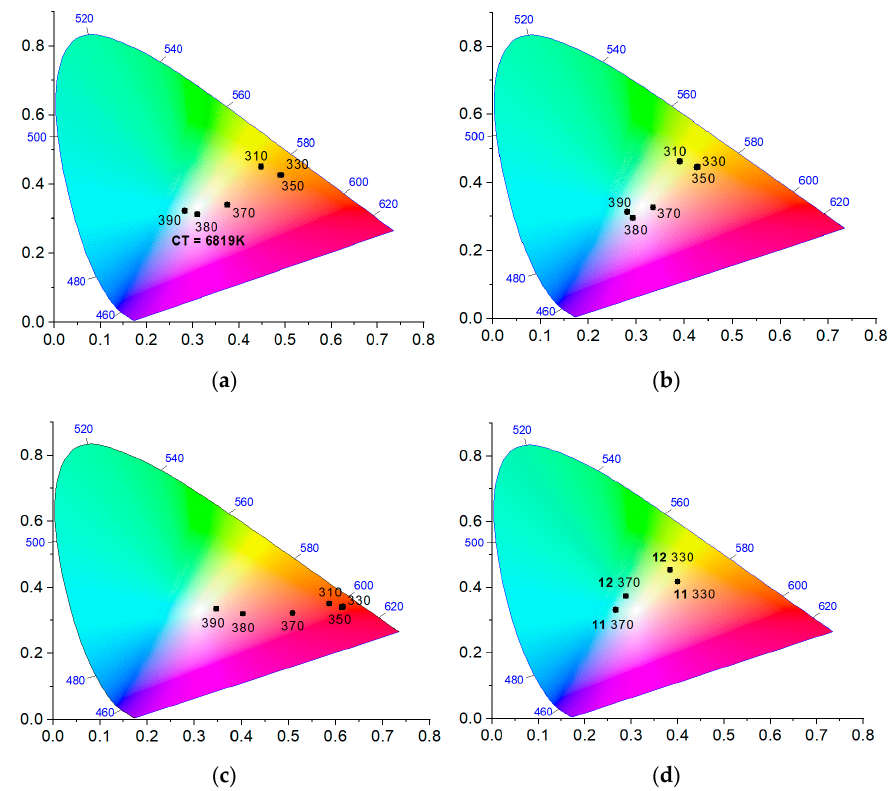
Figure 3. CIE 1931 chromaticity diagrams for trimetallic compositions 8 ( a ), 9 ( b ), 10 ( c ), 11 and 12 ( d ) at different excitation wavelengths.